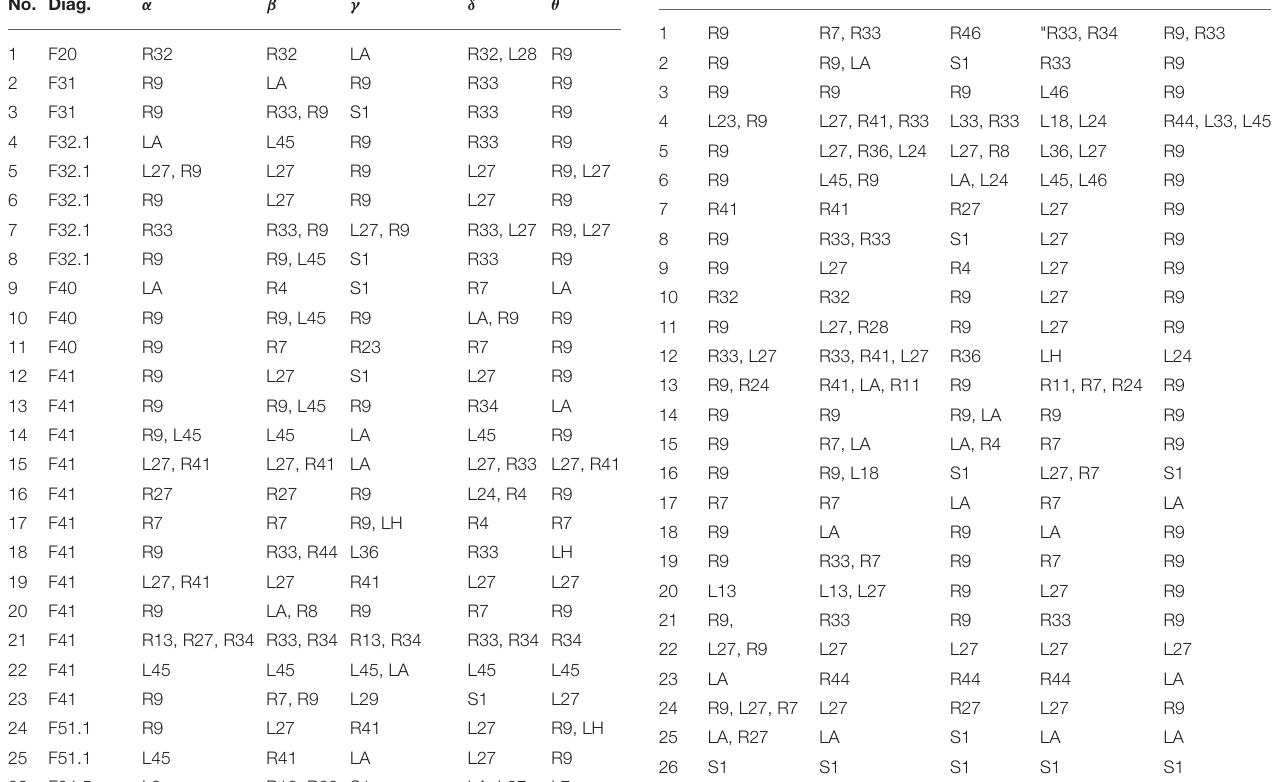
TABLE 1 | Most active BA in particular subjects of patients group during the digit-span task experiment in the alpha, beta, gamma, delta, and theta EEG bands. No. Diag.